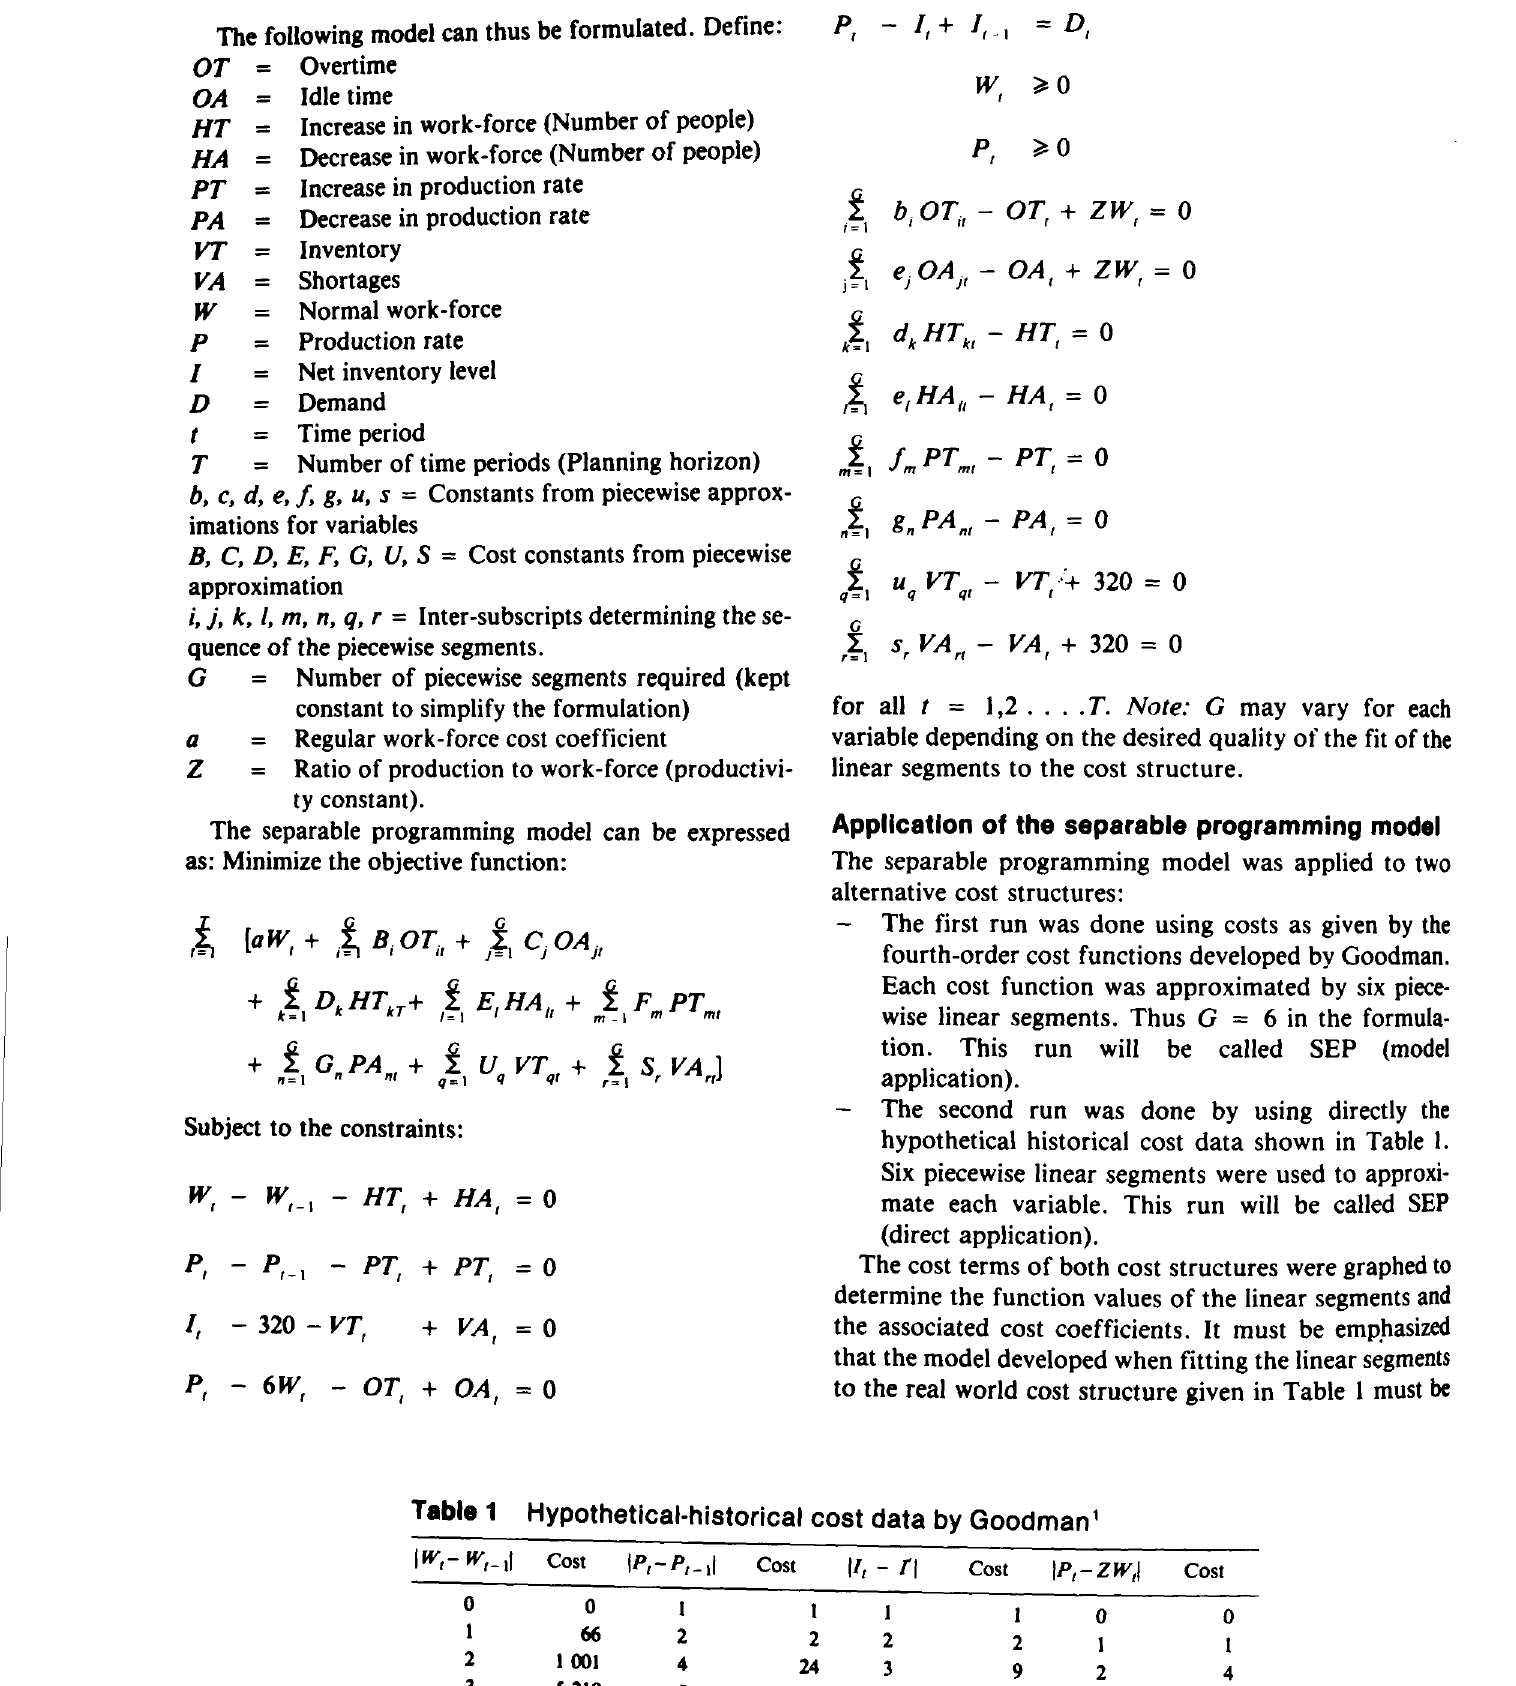
Hypothetical-historical cost data by Goodman